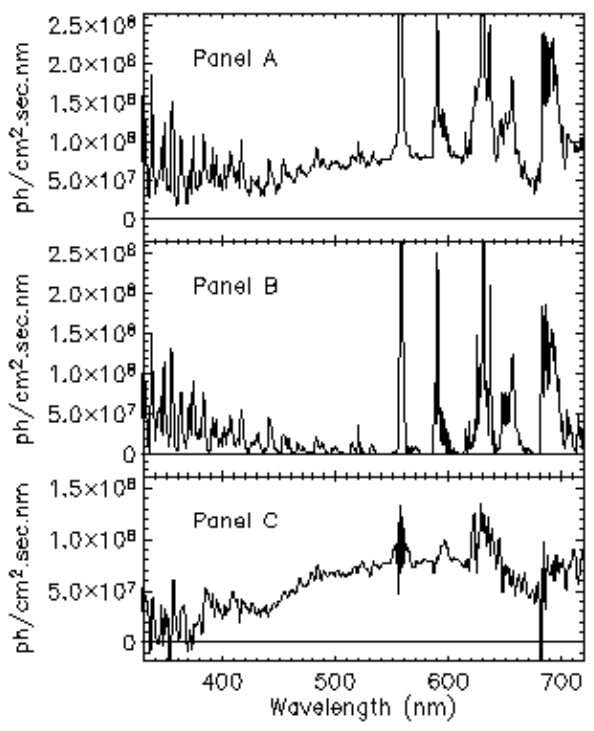
Fig. 2. (A) The averaged night airglow limb spectrum from the Ari- zona GLO-1 spectrograph on-board STS 53, approximately over the 85km to 95km altitude range. (B) Simulated night airglow spec- trum to match the known spectral features in (A) . (C) Panel (A) ob- served spectrum minus panel (B) model spectrum. The difference spectrum is spectrally convolved with a 1.3nm half width triangular function to improve figure clarity. Narrow spectral artifacts remain at the locations of the bright airglow atomic lines. The residual is a “continuum” with a broad peak near